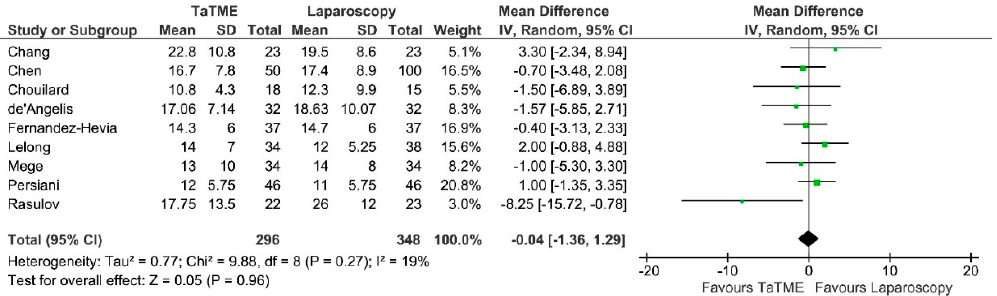
Figure 9. Number of harvested lymph nodes. CI—Confidence Interval; df—degrees of freedom;